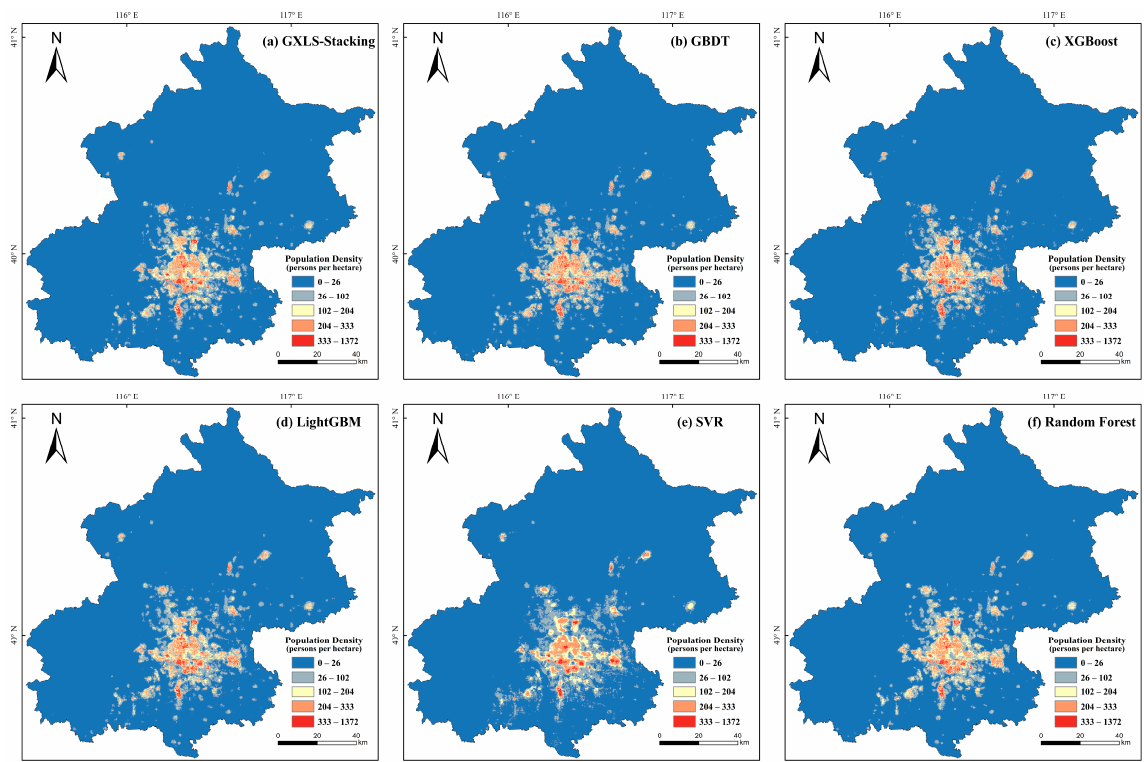
Figure 5. The 100 m spatial resolution distribution weight layers predicted by the optimal models.